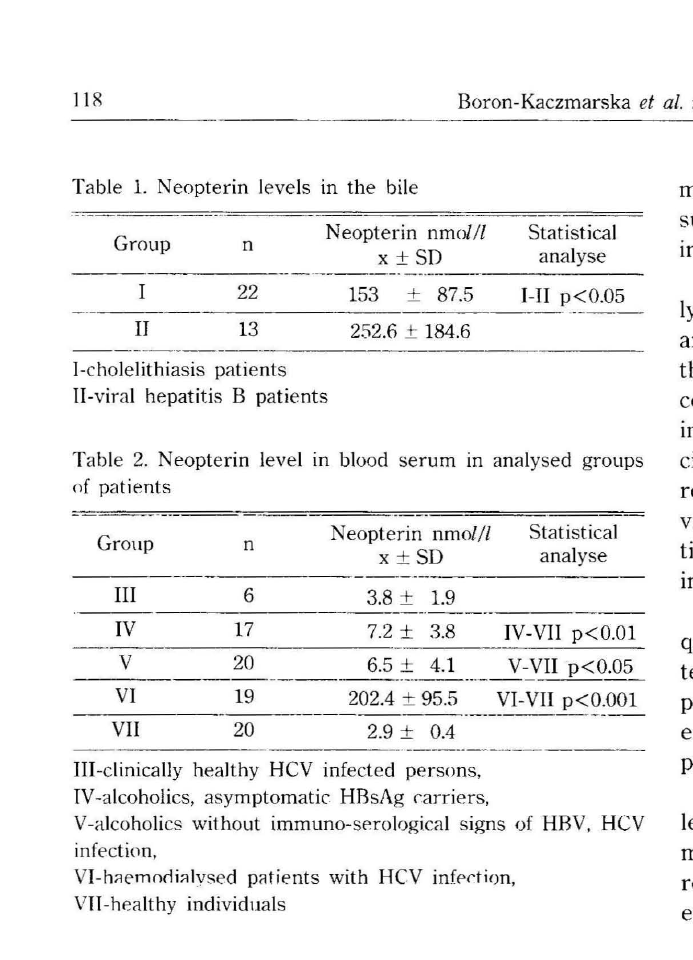
Table 1. Neopterin levels in the bile Group